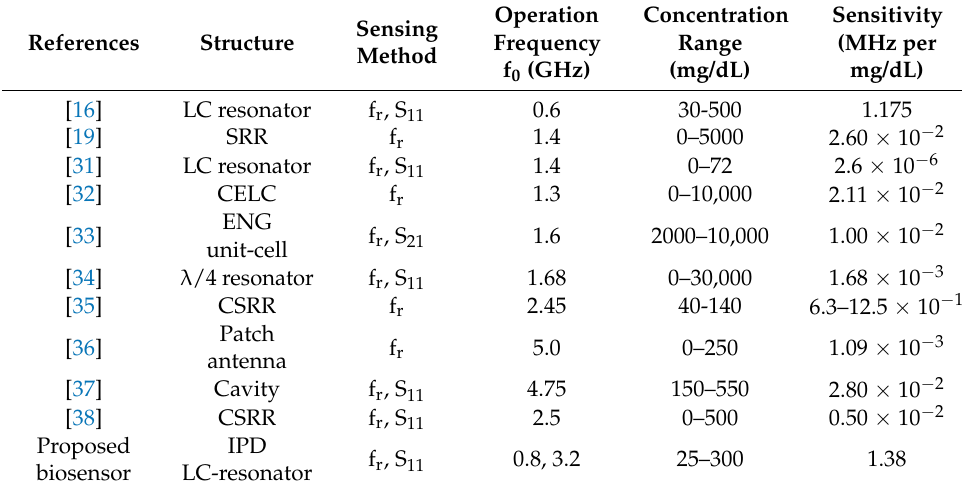
Table 2. Comparison of glucose biosensor